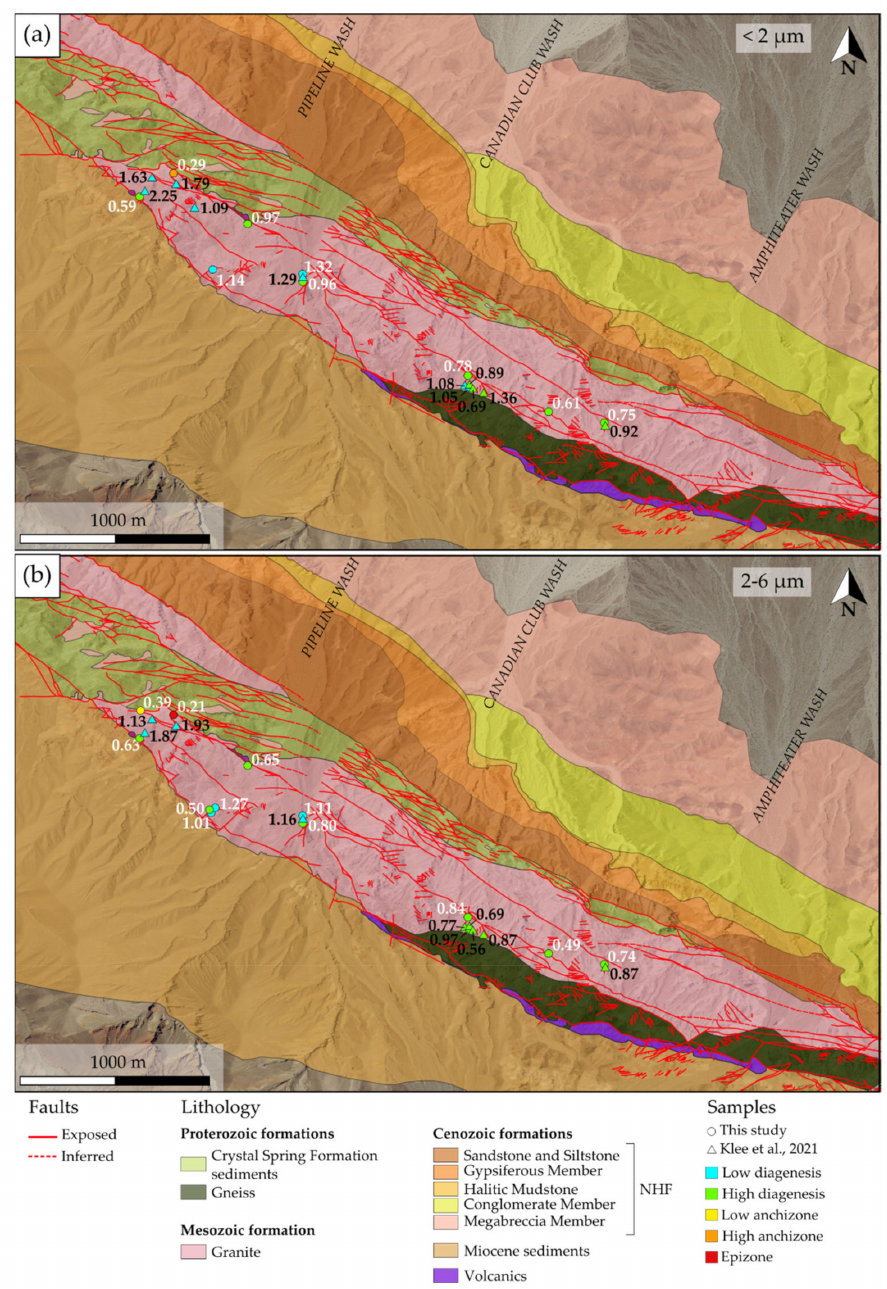
Figure 17. Geological map representing the Kübler Index (KI) in air-dried conditions of each sample from this study (dots) and from [19] (triangles) and the corresponding metamorphic zone represented by the different colors indicated in the legend for ( a ) the fraction <2 µ m and ( b ) the fraction 2–6 µ m. Some samples contain only kaolinite and no illite. Positive trends have been identified between KI and KCI for both clay fractions <2 µ m and 2–6 µ m (Figure 18). Samples NH_6, NH_8, and NH_31_1_2, with out of range values, due to the presence of I/S and/or corrensite interfering with the 7Å peak, were excluded from the correlation. The trends observed in the two different fractions are similar and give more confidence into the concomitant evolution of KI and KCI. The correlation provides temperature indications for illite-free samples. Thus, samples NH_26, NH_33, and NH_36 show values equivalent to diagenetic zone and anchizone